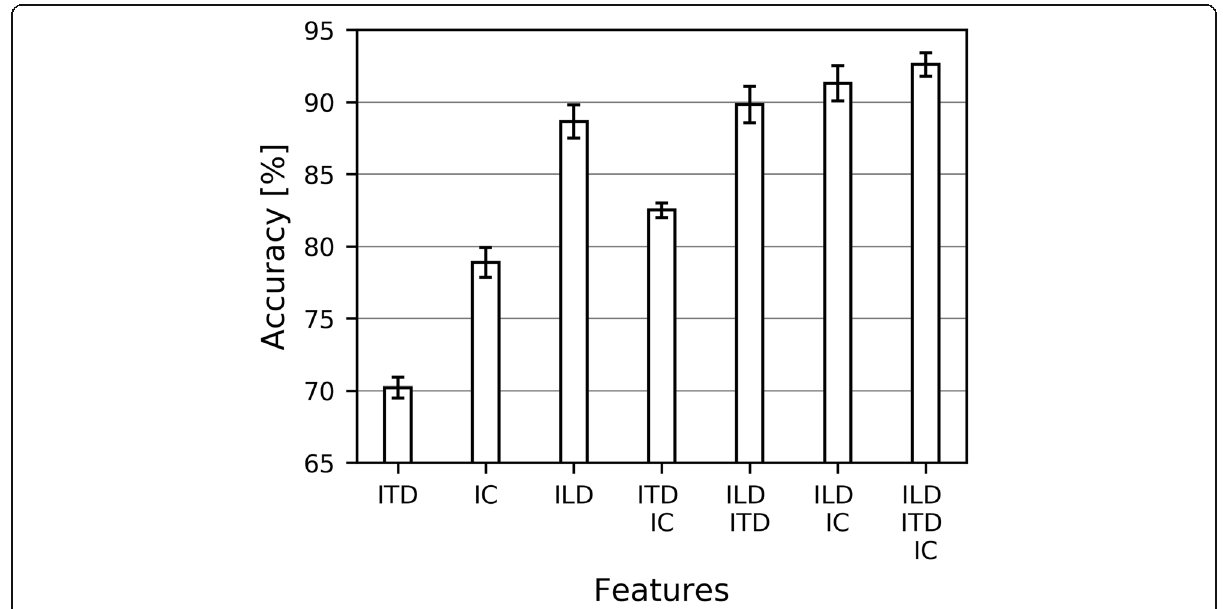
Fig. 7 Mean classification accuracy scores obtained for binaural cues (Logit classifier). Error bars denote standard